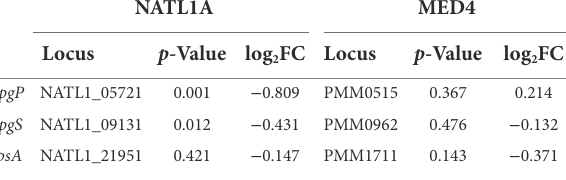
TABLE 4 Expression change on genes responsible for compatible solute